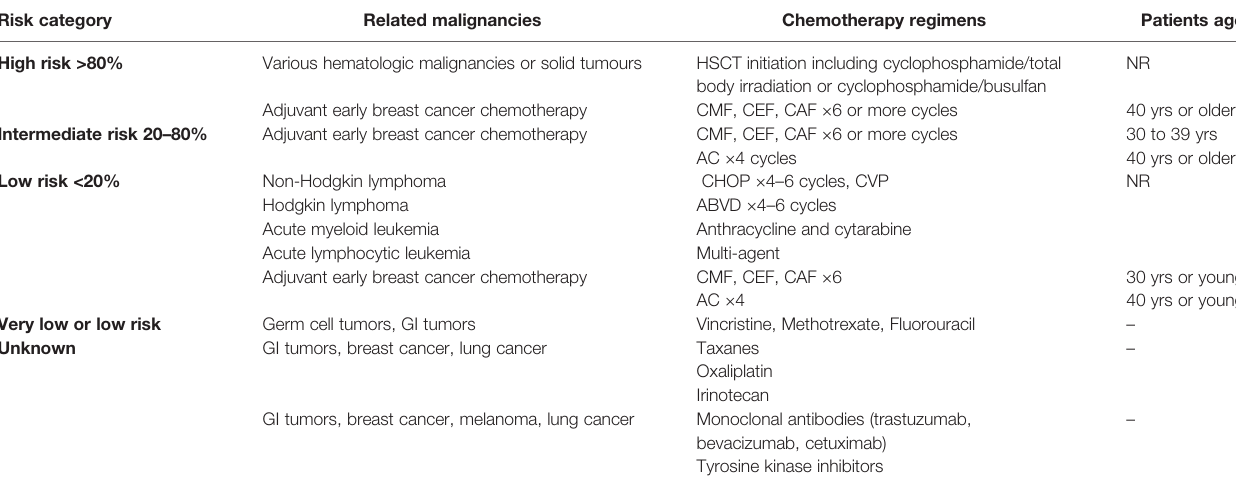
TABLE 1 | Risk of infertility associated with antineoplastic systematic treatment [based on American Society of Clinical Oncology Recommendations on Fertility Preservation in Cancer Patients, (6). Risk